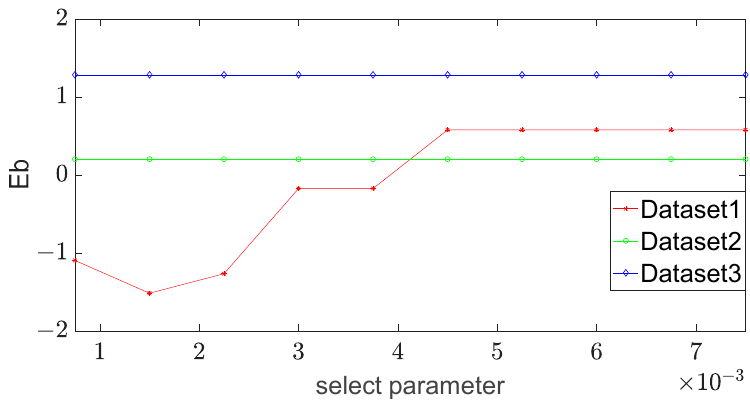
Figure 8. The error of the short axis vs. select parameter in different datasets.